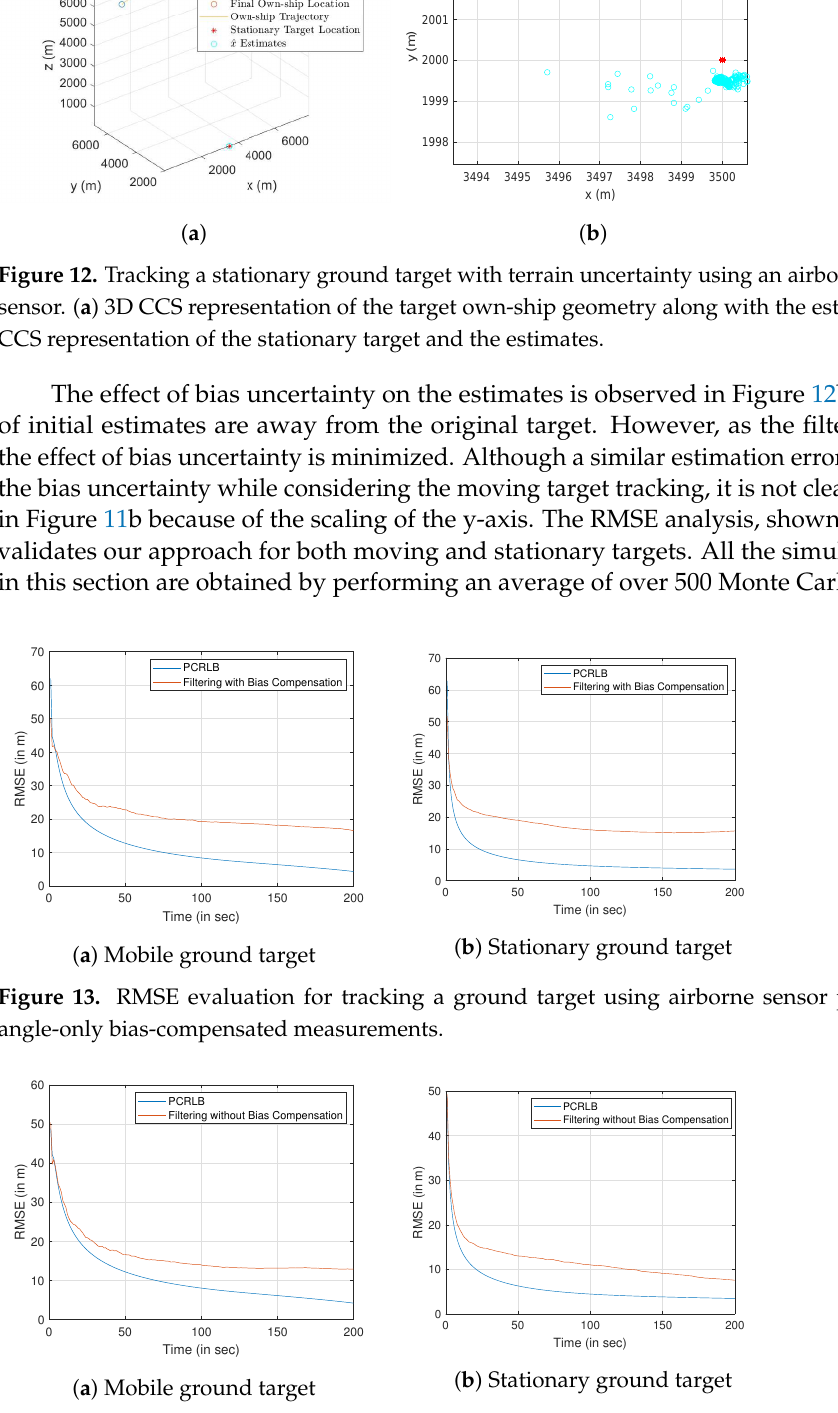
Figure 14. RMSE evaluation for tracking a ground target using an airborne sensor platform with unbiased angle-only